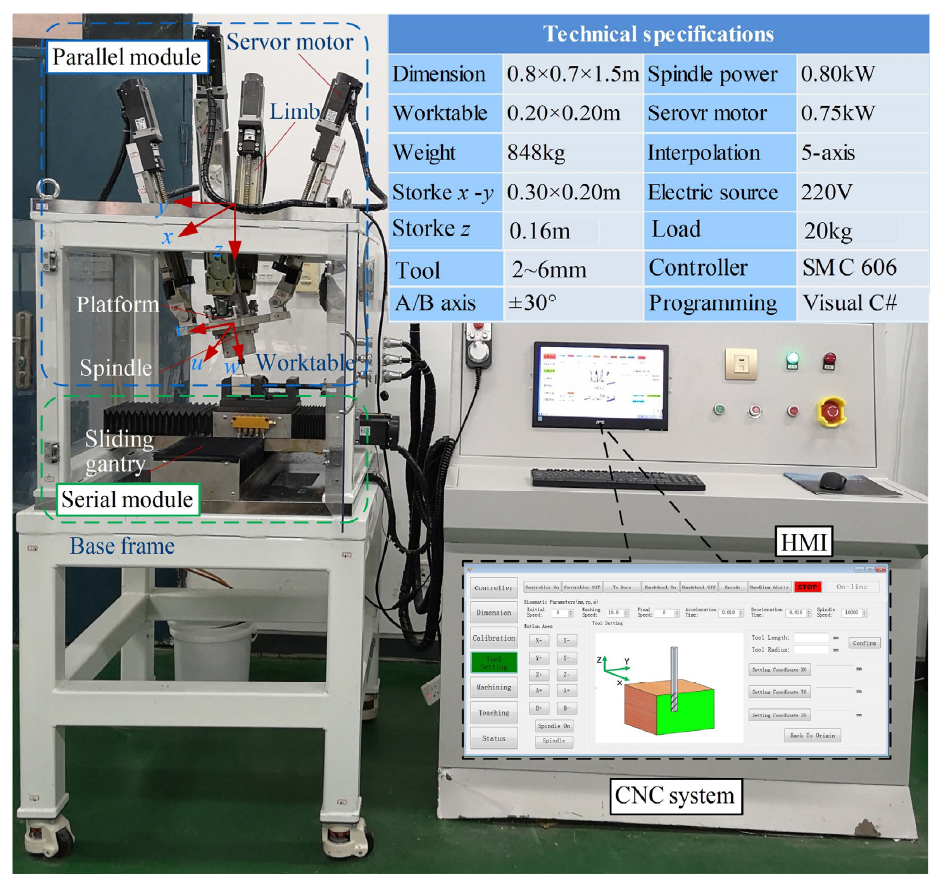
Figure 3. A full-scale prototype of the five-axis HKMU.